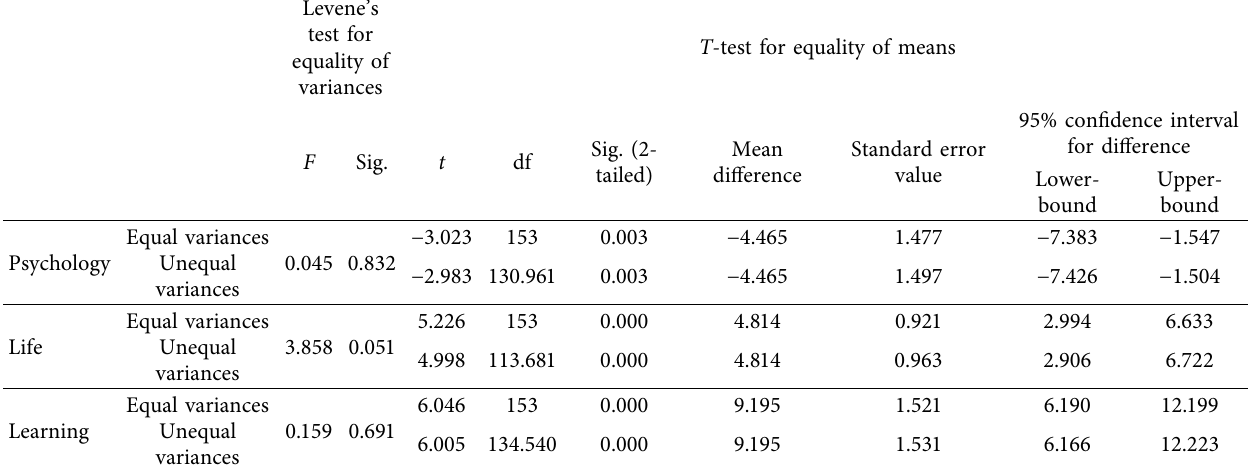
Table 3: Levene’s test & T -test for the equality of